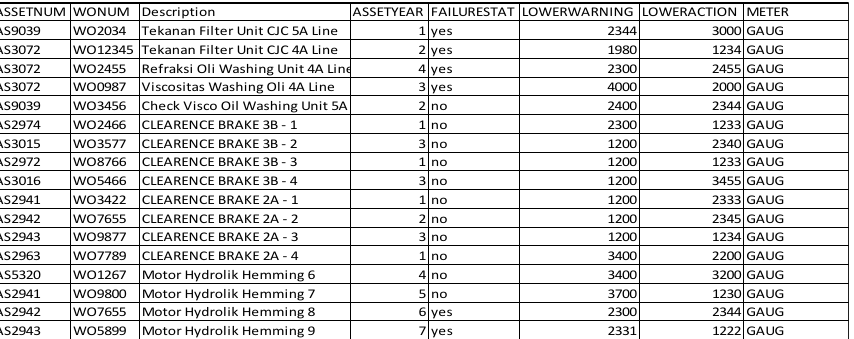
Table 1. Examples of data to be used in